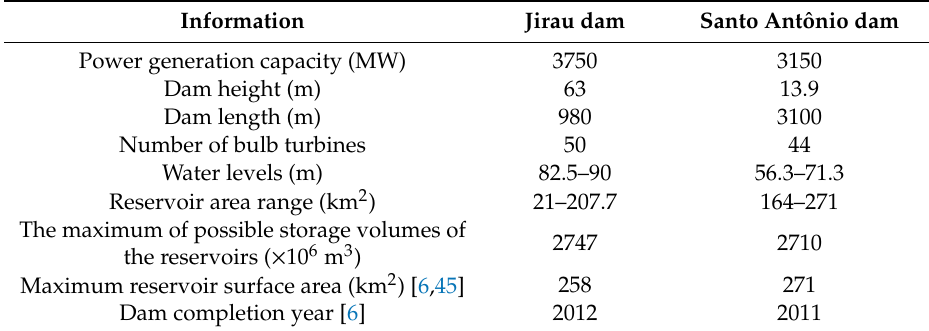
Table 1. Key characteristics of the Jirau dam and Santo Ant ô nio